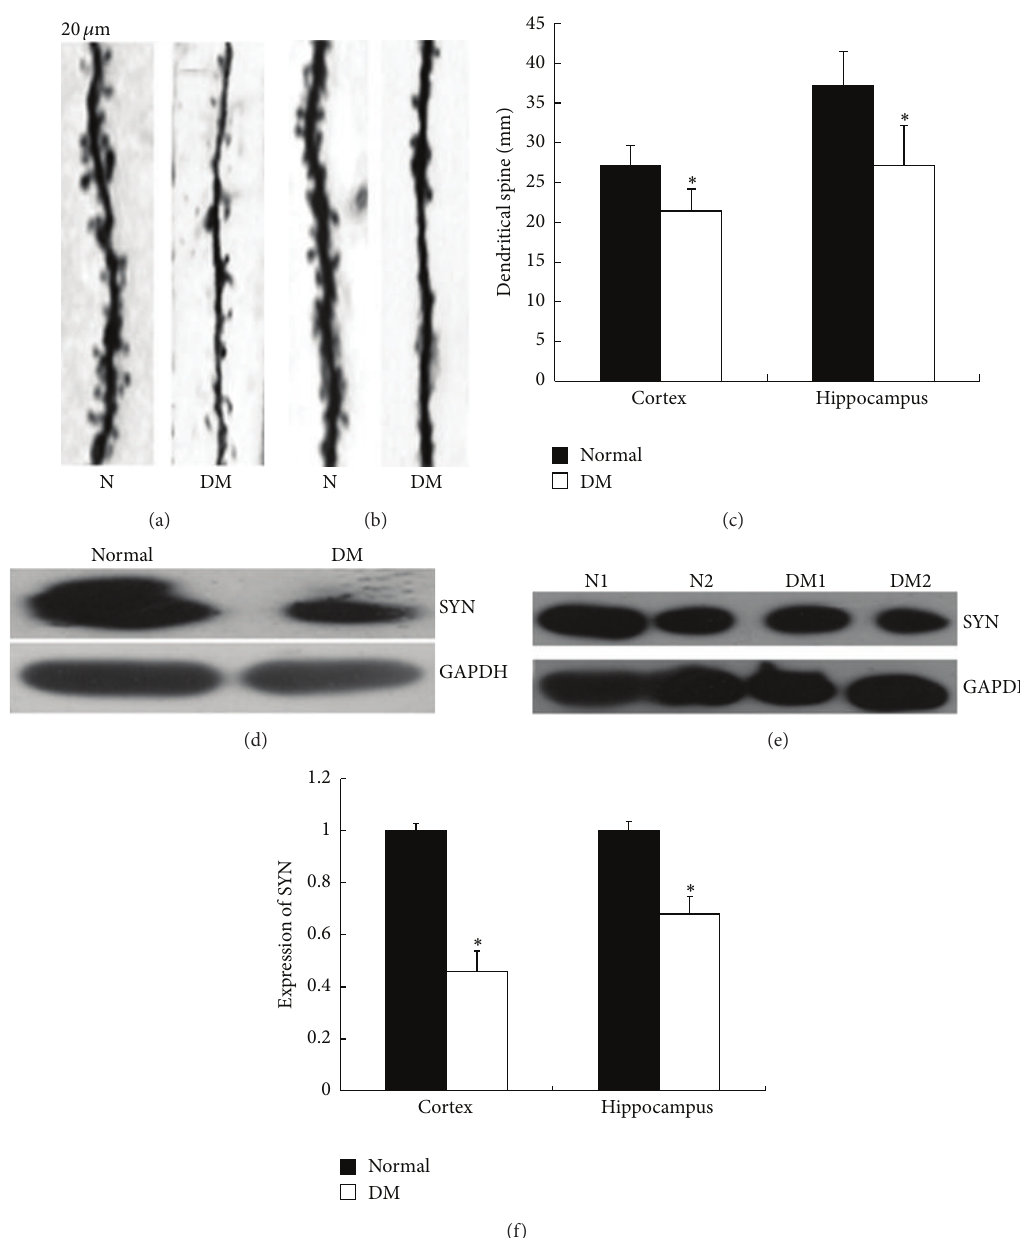
Figure 5: Decline in dendritic spine density in the frontal cortex and hippocampus of rats at 4 months after STZ injection. (a) Representative imagesofthedendriticspineofthepyramidalneuronsincorticallayersII/III.(b)Representativeimagesofthedendriticspineofthepyramidal neuronsintheCA1regionofthehippocampus.(c)Dendriticspinedensityinthefrontalcortexandhippocampuswasmeasured(seeMaterials and Methods for procedure details). ∗ 𝑃 < 0.05 , significant difference compared with the age-matched control rats; 𝑛 = 4 . (d) Representative images of synaptophysin expression in the frontal cortex using western blot analysis. (e) Representative images of synaptophysin expression in the hippocampus using western blot analysis. (f) Relative expression of synaptophysin in the frontal cortex and hippocampus was determined. ∗ 𝑃 < 0.05 , significant difference compared with the age-matched control group; 𝑛 = 4